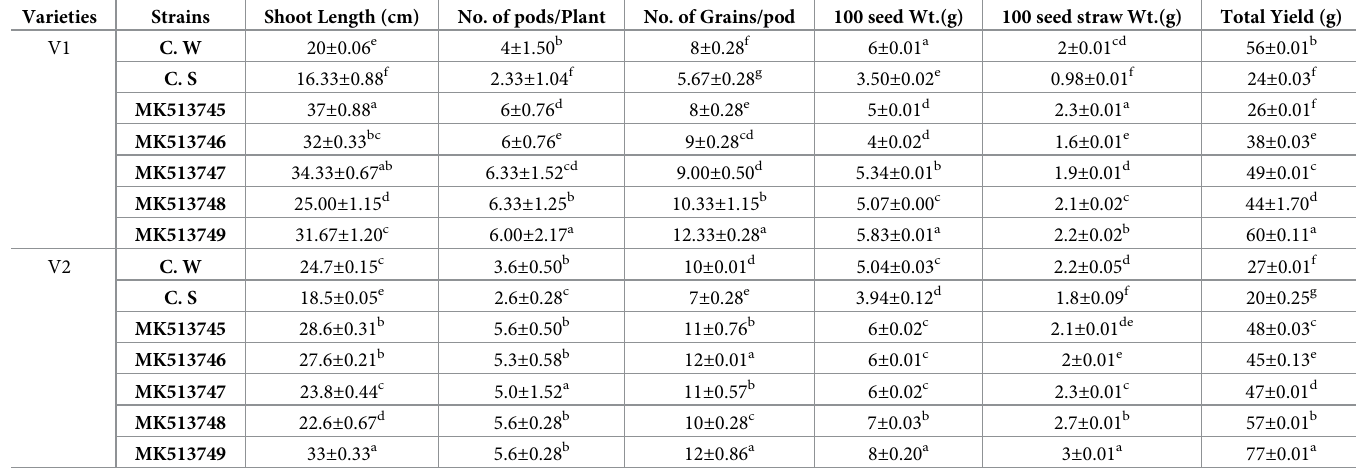
Lipid peroxidative enzymes. Lipid peroxidation in leaf tissues was calculated in form of malondialdehyde (MDA) and hydrogen peroxide content. There was a significant difference between malondialdehyde (MDA) contents of control watered (C.W) and control stressed (C. S) plants (29 and 67 mmol/g FW), drought stress increased malondialdehyde (MDA) content in leaves of stressed control plants with 134% increase over C.W plants. Inoculated PGPR exhibited up-to 54%, 56% decrease in MDA content of V1 and V2 respectively as compared to stressed plants and tried to reduce lipid peroxidation and maintain its content like in control Table 5. Effect of IAA producing plant growth promoting rhizobacteria on growth and yield parameter of two varieties of Vigna radiata in field trials. Varieties Strains